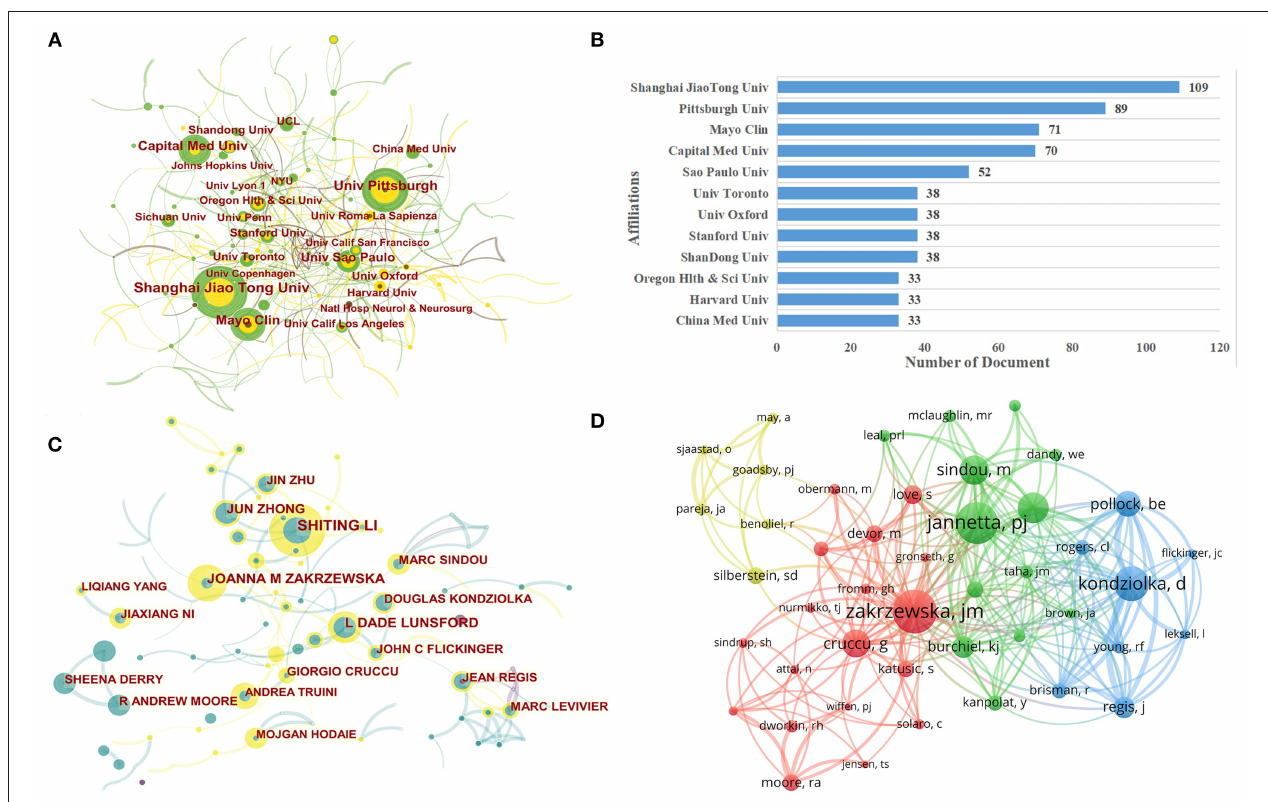
FIGURE 2 | (A) The co-authorship network visualization map of institutions for trigeminal neuralgia (TN) research. (B) Top 12 most productive institutions between 2001 and 2021. (C) A CiteSpace visualization map of authors involved in TN. (D) A VOSviewer visualization map of co-cited authors involved in TN.